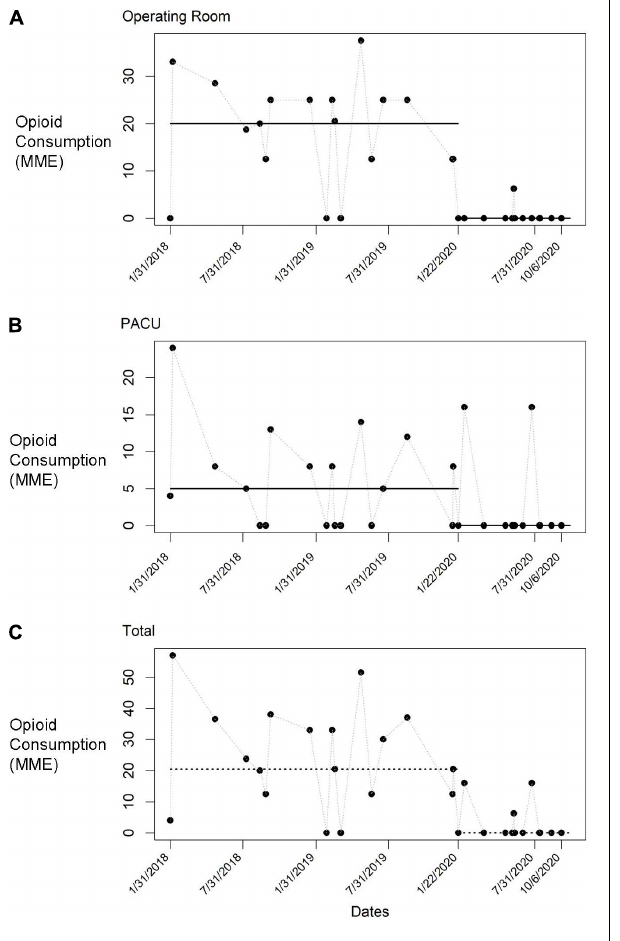
FIGURE 2 | Run charts of opioid consumption before implementation and throughout multiple tests of change. Each data point represents an individual donor. (A) Morphine milligram equivalents (MME) administered in the operating room. (B) MME administered in the post anesthesia care unit (PACU). (C) MME administered in all phases of